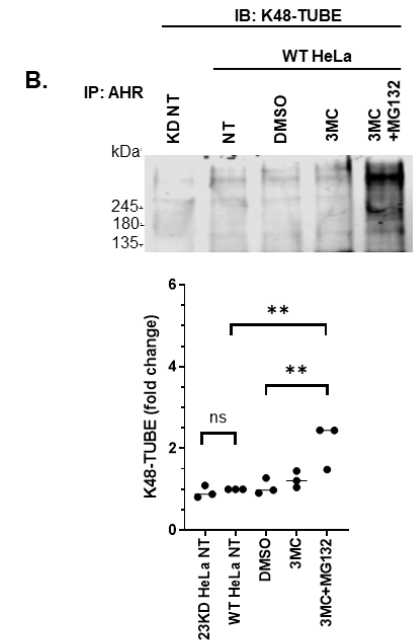
NC, negative control (cells incubated without antibodies against interaction partners); NT, no